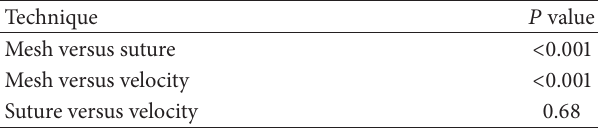
Figure 1: Attachment of port to mesh.